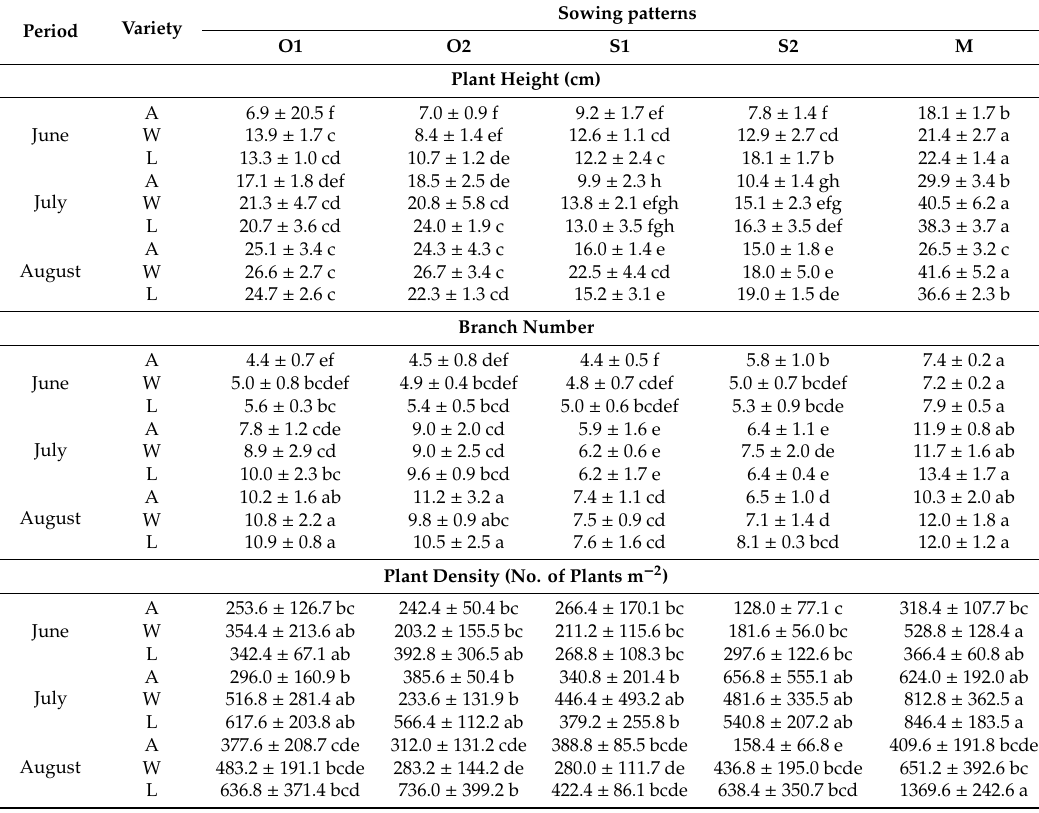
Table 3. Plant height, branch number and plant density of alfalfa in all